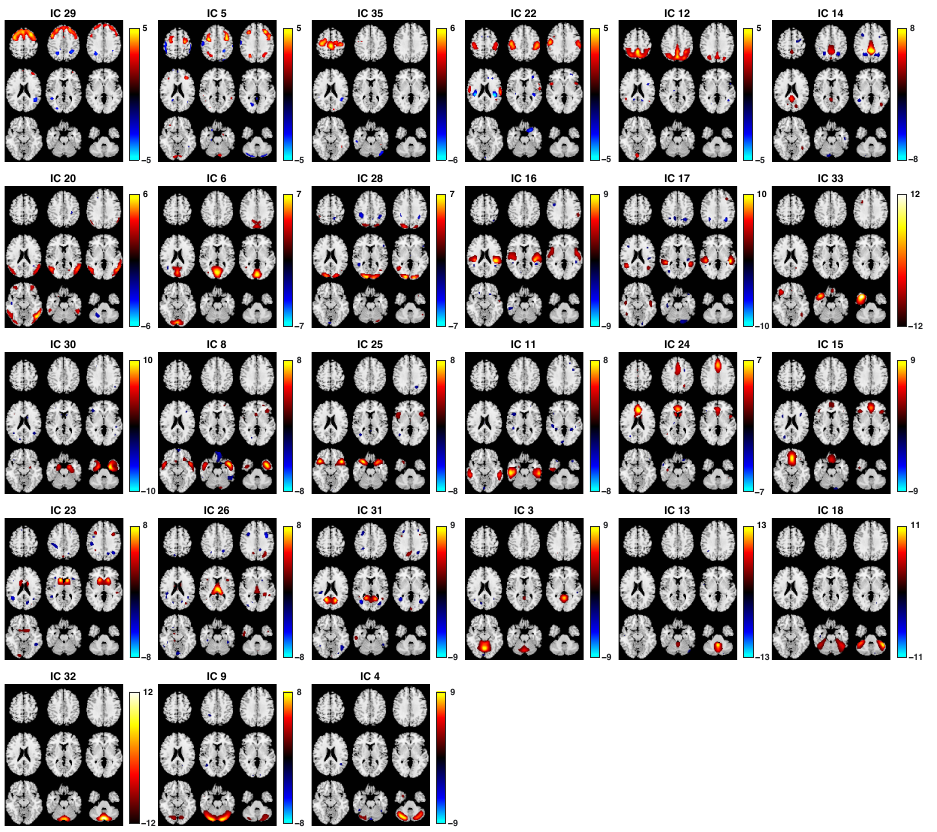
Figure 5. Spatial maps of 27 retained ICs from the GM dataset. These results reflect the IC results of SZ and HC groups combined. The brain maps are visualized at color and negative Z values in blue.